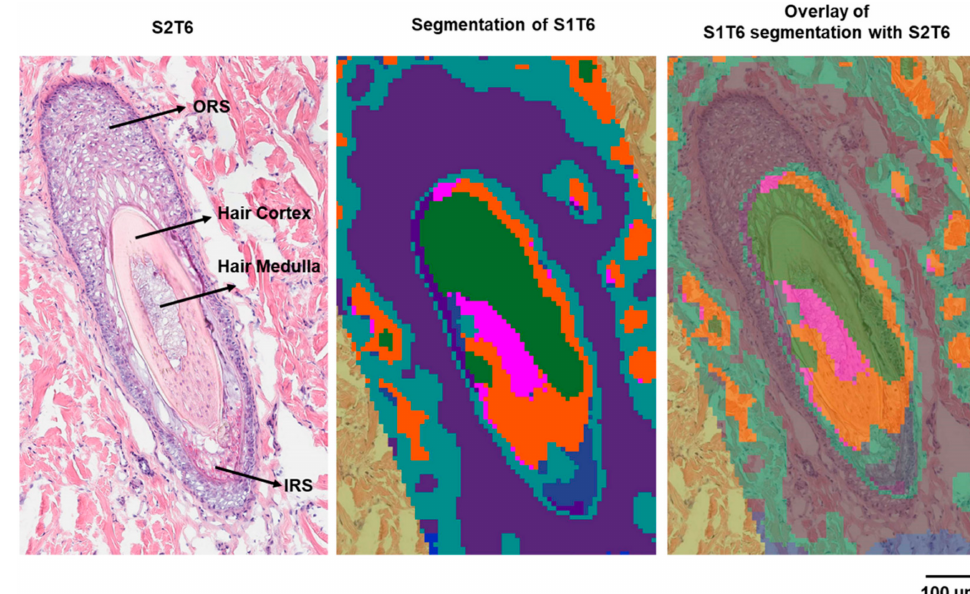
Figure 5. Histology and segmentation analysis of hair